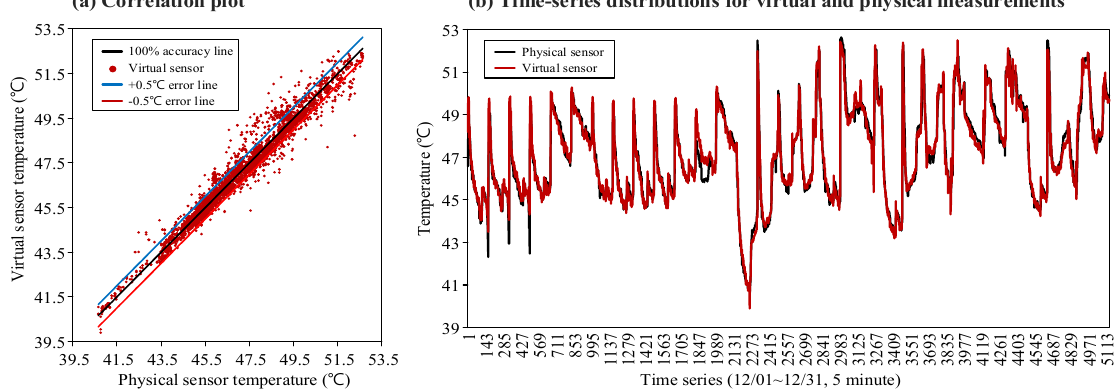
Figure 2. Accuracy of the target virtual sensor during the development period (December 2020).